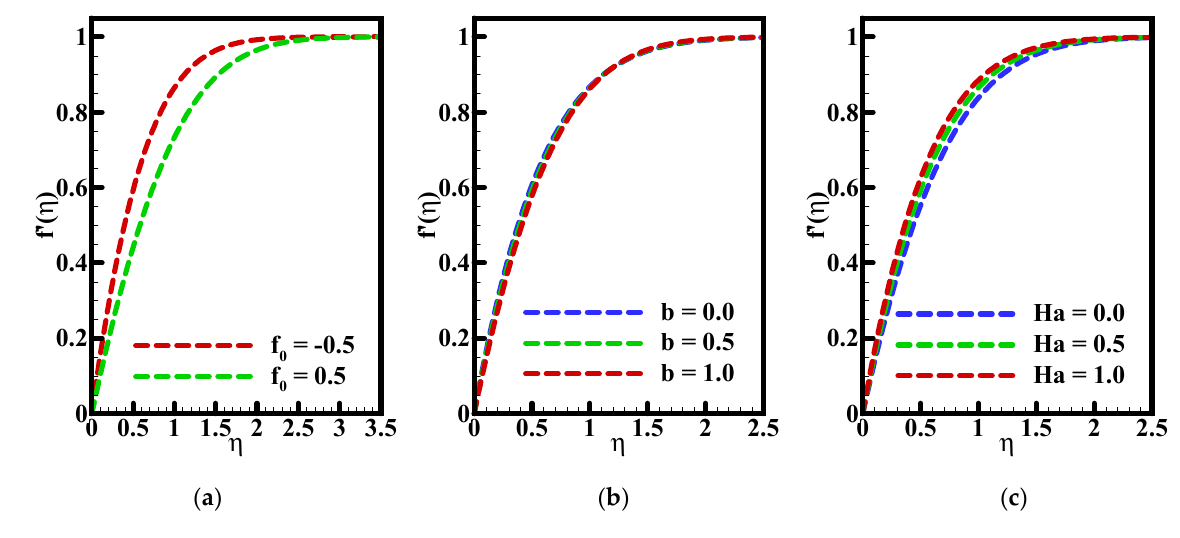
Figure 2. Impact of the parameters ( a ) f 0 , ( b ) b , and ( c ) Magnetic parameter ( Ha ) on the dimensionless velocity profile and numerous choices of emerging parameters. Table 1. The behavior of the physical quantities of skin friction, the Nusselt number, and the Sherwood number under the variation in physical